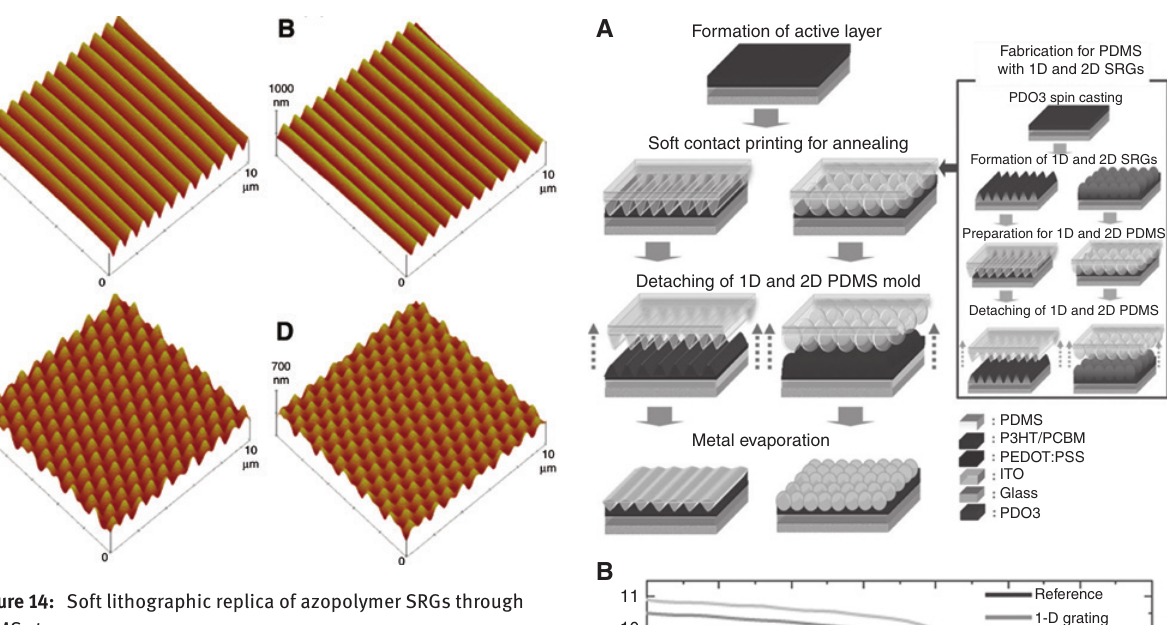
Figure 14: Soft lithographic replica of azopolymer SRGs through PDMS stamps.